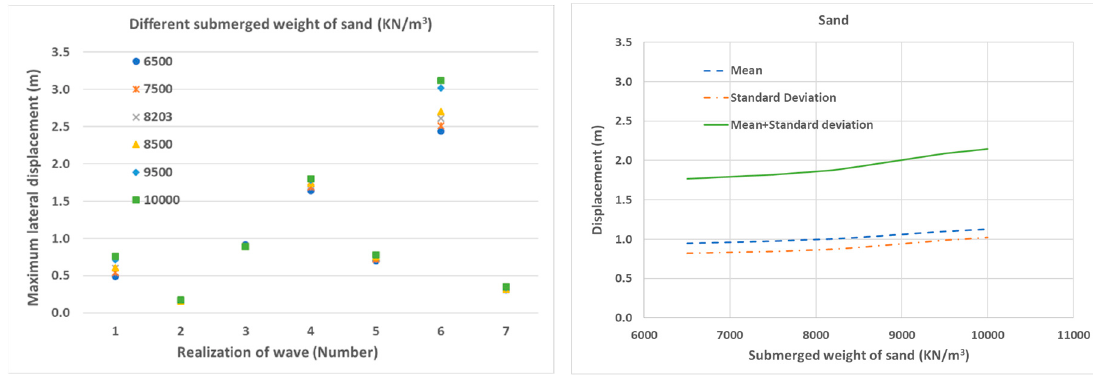
Figure 10. The lateral displacement of the umbilical for seven wave realizations and the mean and standard deviation of lateral displacement (with different submerged weight of sand).